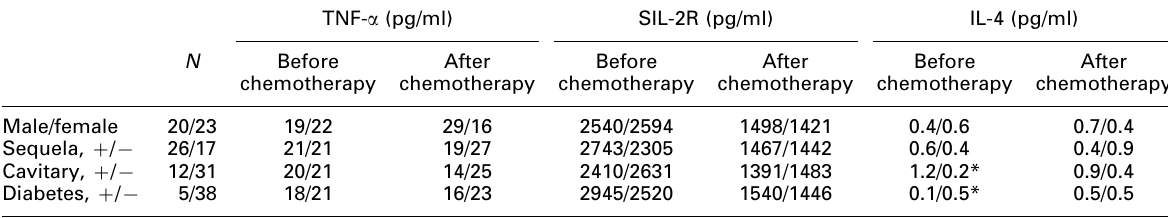
Table 4. Concentrations of TNF- a , SIL-2R and IL-4 according to gender and clinical conditions before and after chemotherapy TNF- a (pg/ml) N Before After Before After Before After chemotherapy chemotherapy chemotherapy chemotherapy chemotherapy